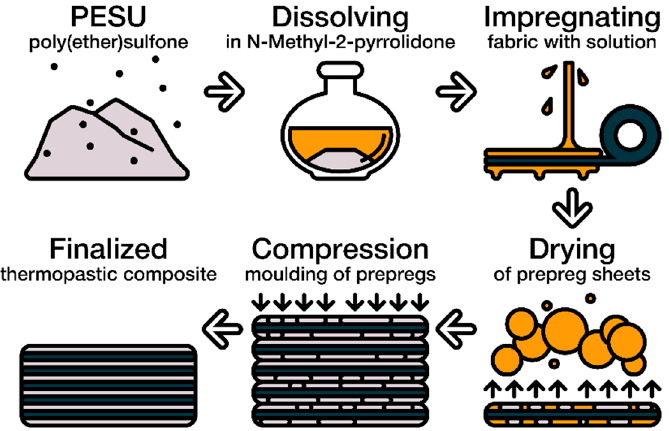
Figure 2. Scheme of obtaining of composite materials.